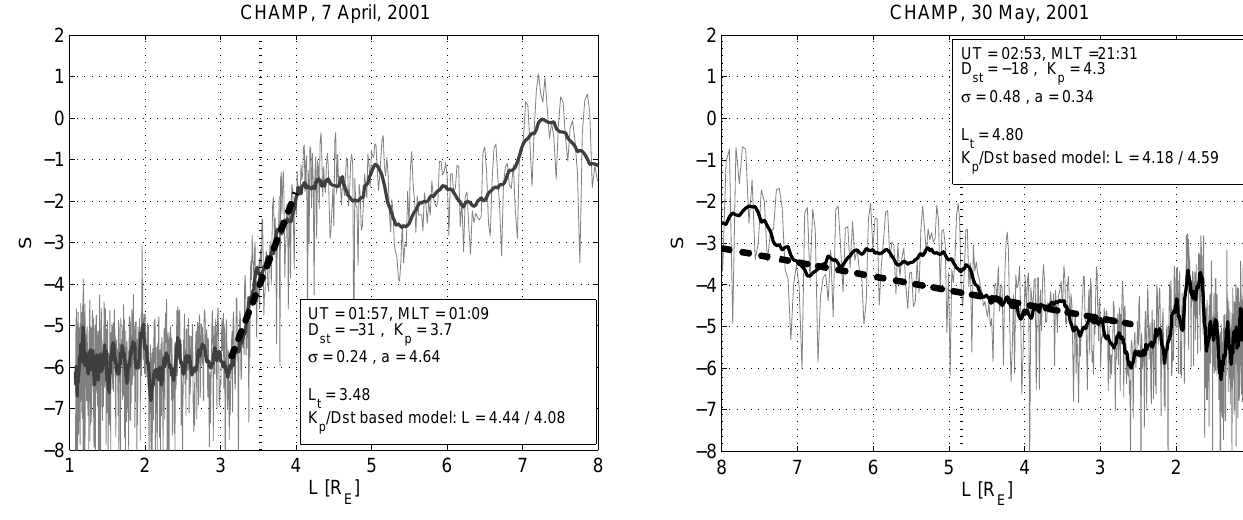
Fig. 2. Well-defined transition of MSFAC activity (data from Fig. 1).